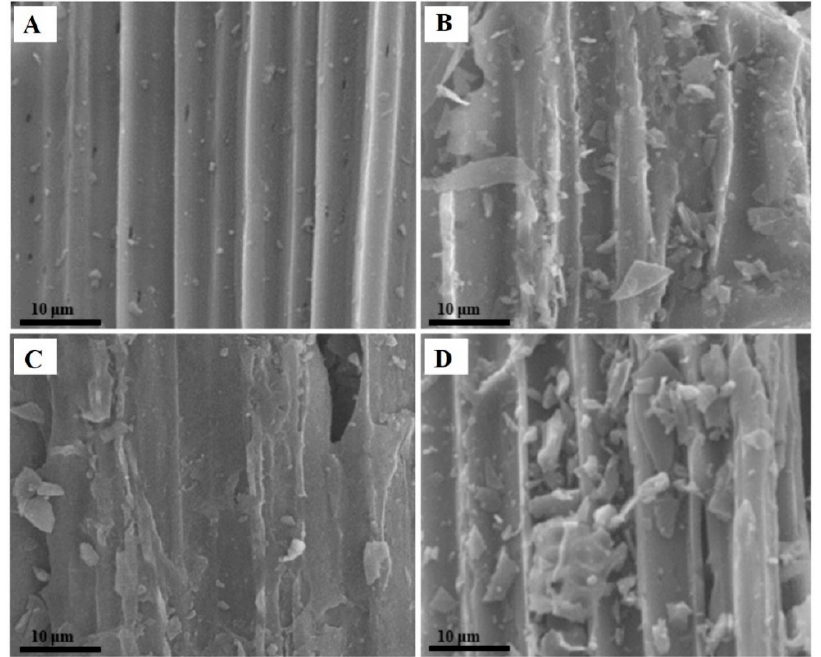
Figure 2. Surface morphology analysis of ( A ) raw corn stalk; ( B ) solid acid catalyst (SAC)-1; ( C ) SAC-2 and ( D ) SAC-3.